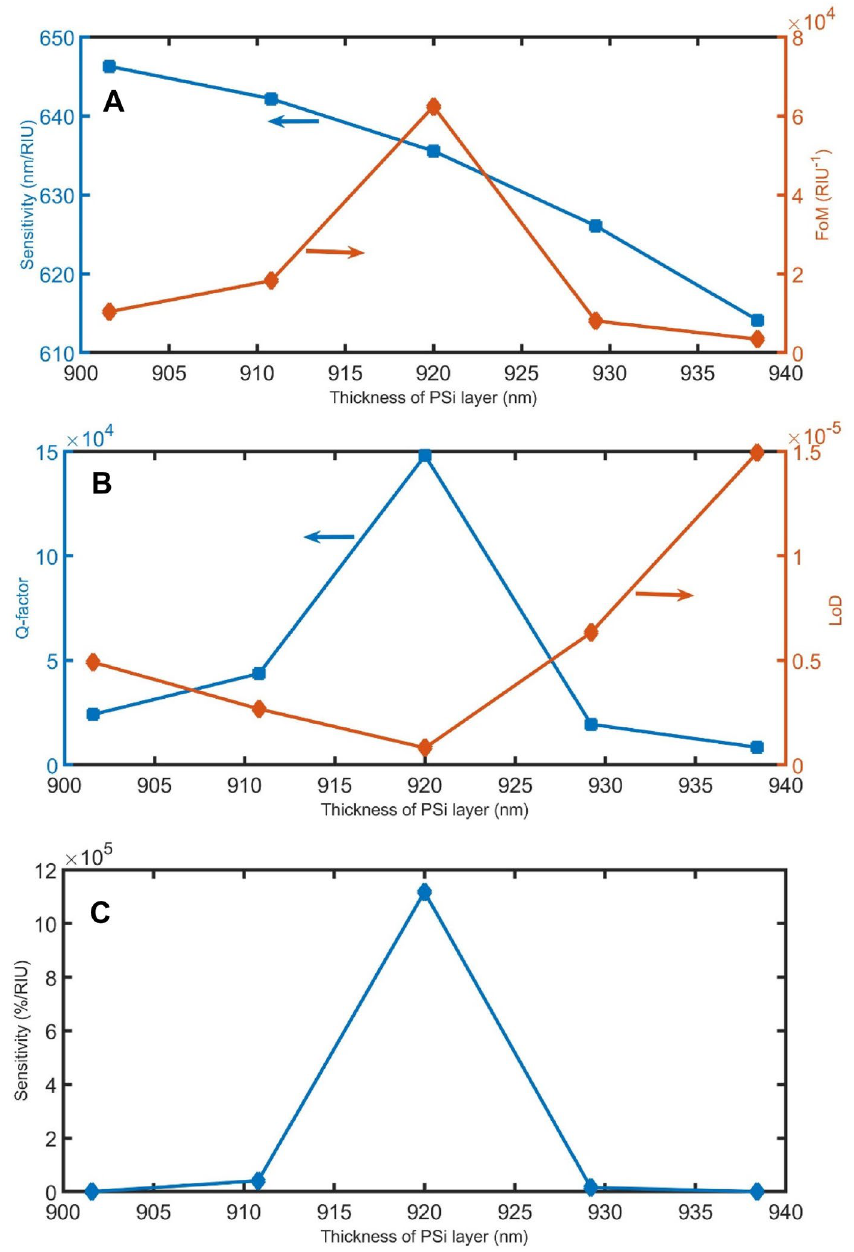
Figure 10. The ( A ) sensitivity in nm/RIU and FoM, ( B ) Q-factor and LoD, and ( C ) sensitivity in %/RIU, with varying the thickness of the PSi